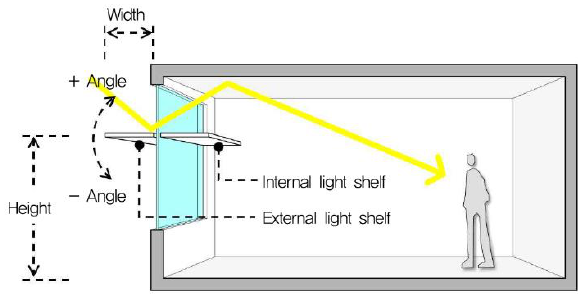
Figure 1. Concept of and variables associated with a light shelf.